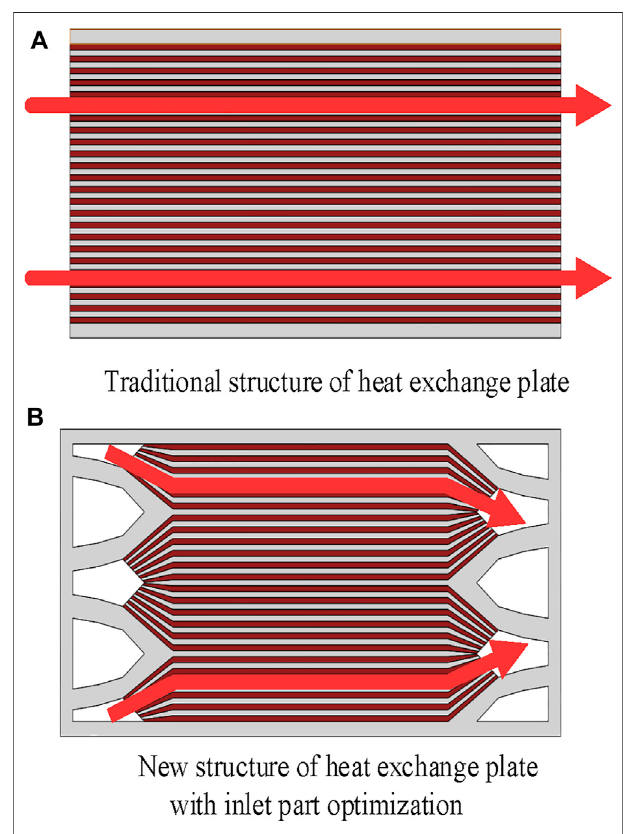
FIGURE13| Structure optimizationoftheinletpartintheheatexchange plate. (A) Traditionalstructureoftheheatexchangeplate. (B) Newstructureof the heat exchange plate with inlet part